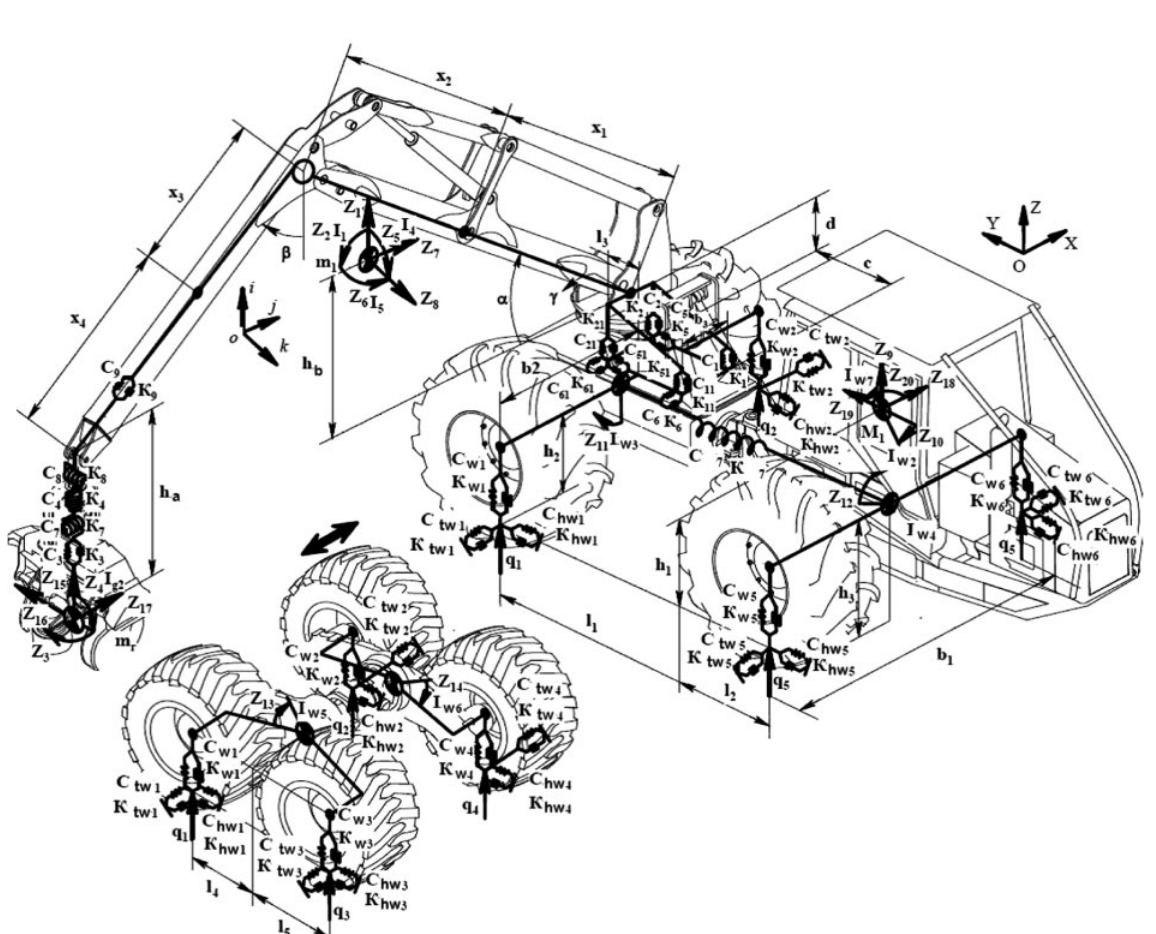
Fig. 2. Diagram of spatial dynamic model of harvester 4 (cid:1) 4 and 6 (cid:1)